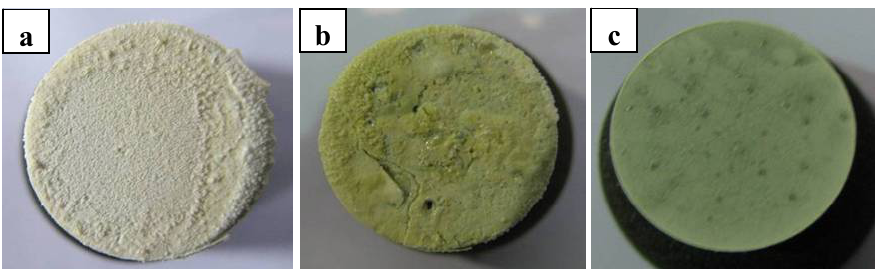
based ultra high temperature ceramic composites 2